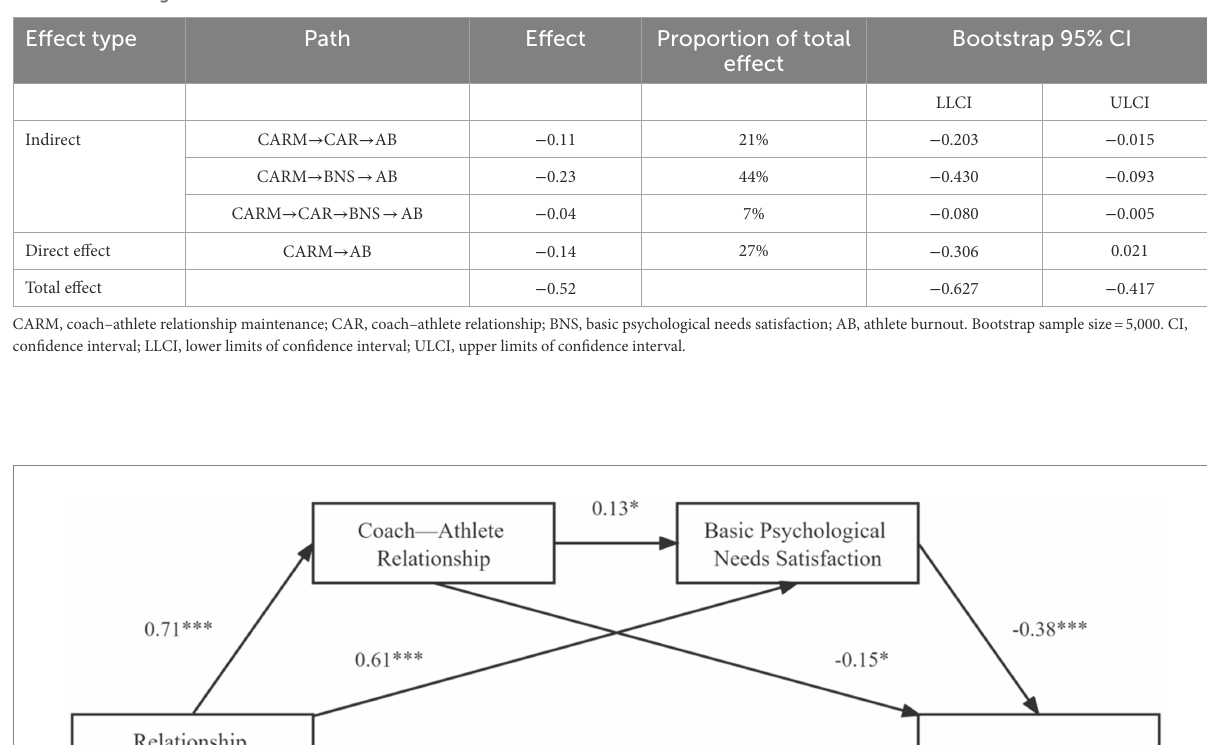
TABLE 3 Mediating effect